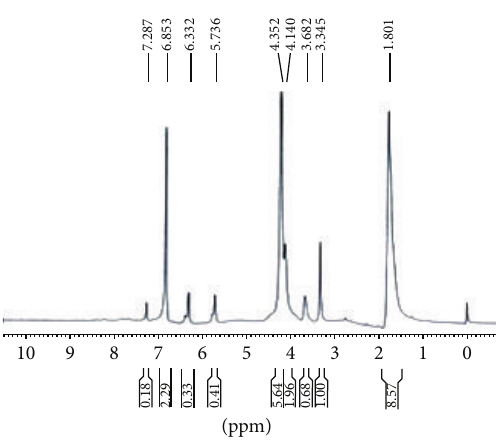
Figure 2: 1 H-NMR spectrum of copolyester PIFB.